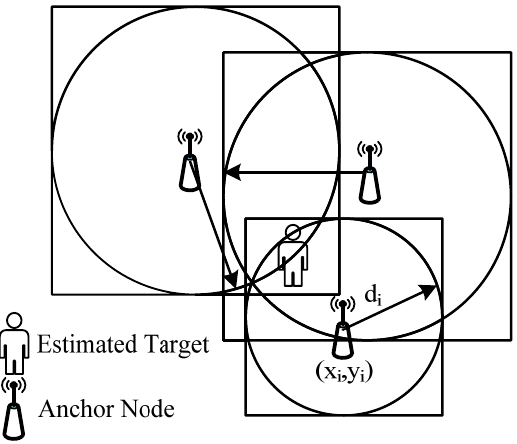
Appl. Sci. 2020 , 10 , x FOR PEER REVIEW